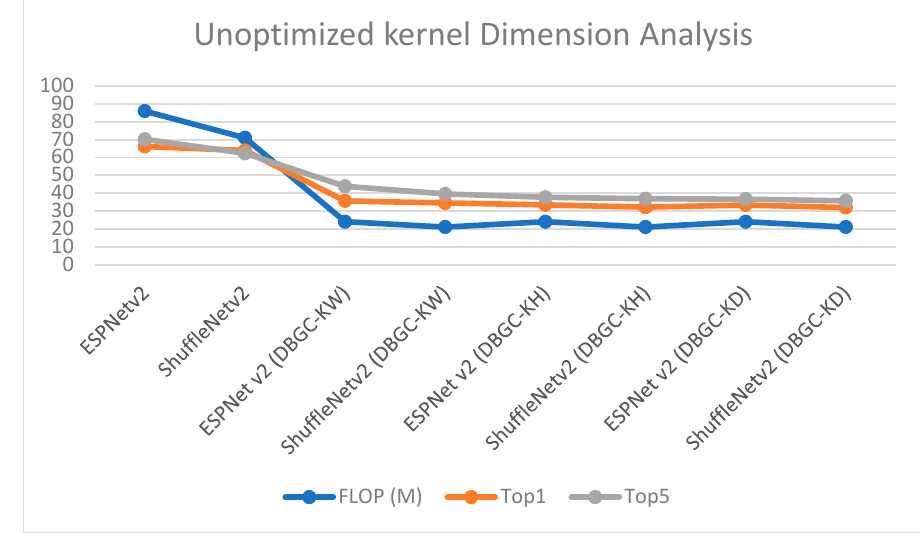
Figure 18. Analysis of unoptimized kernel dimensions.